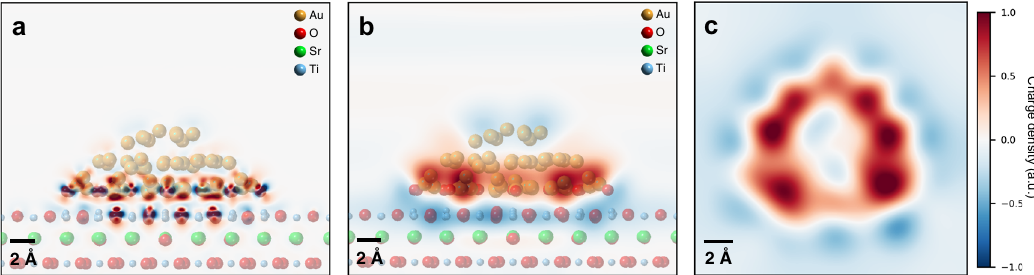
Fig. 5 Charge transfer at a (111)-oriented Au nanoparticle/(001)-oriented STO support interface, with additional oxygen at the particle perimeter, calculated by DFT. a Additional oxygen atoms around the perimeter of the particle, emulating the O-treated case, signi fi cantly alter the charge transfer features of the system in Fig. 3. b The sign of the net charge on the particle and support is inverted, with the particle positive and the support negative. c In top-down projection, the positive features appear mainly localized to the particle perimeter, consistent with the experimental results.